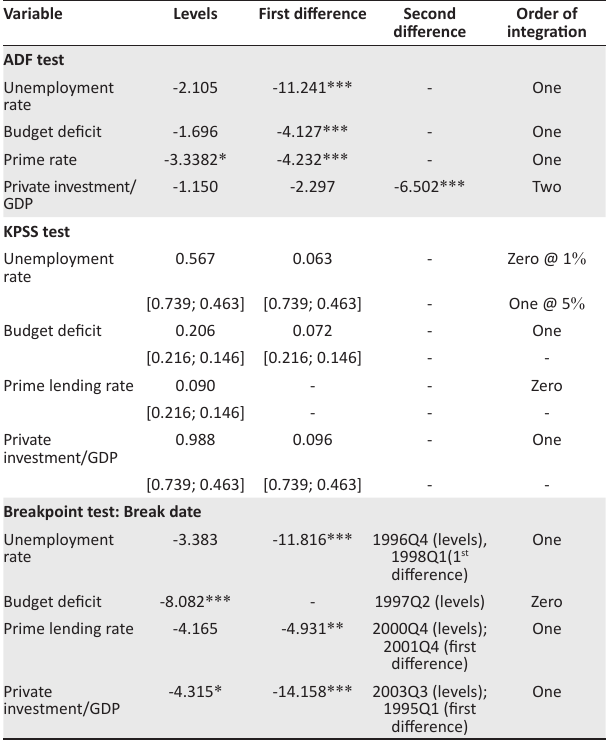
TABLE 1: Unit root tests, intercept